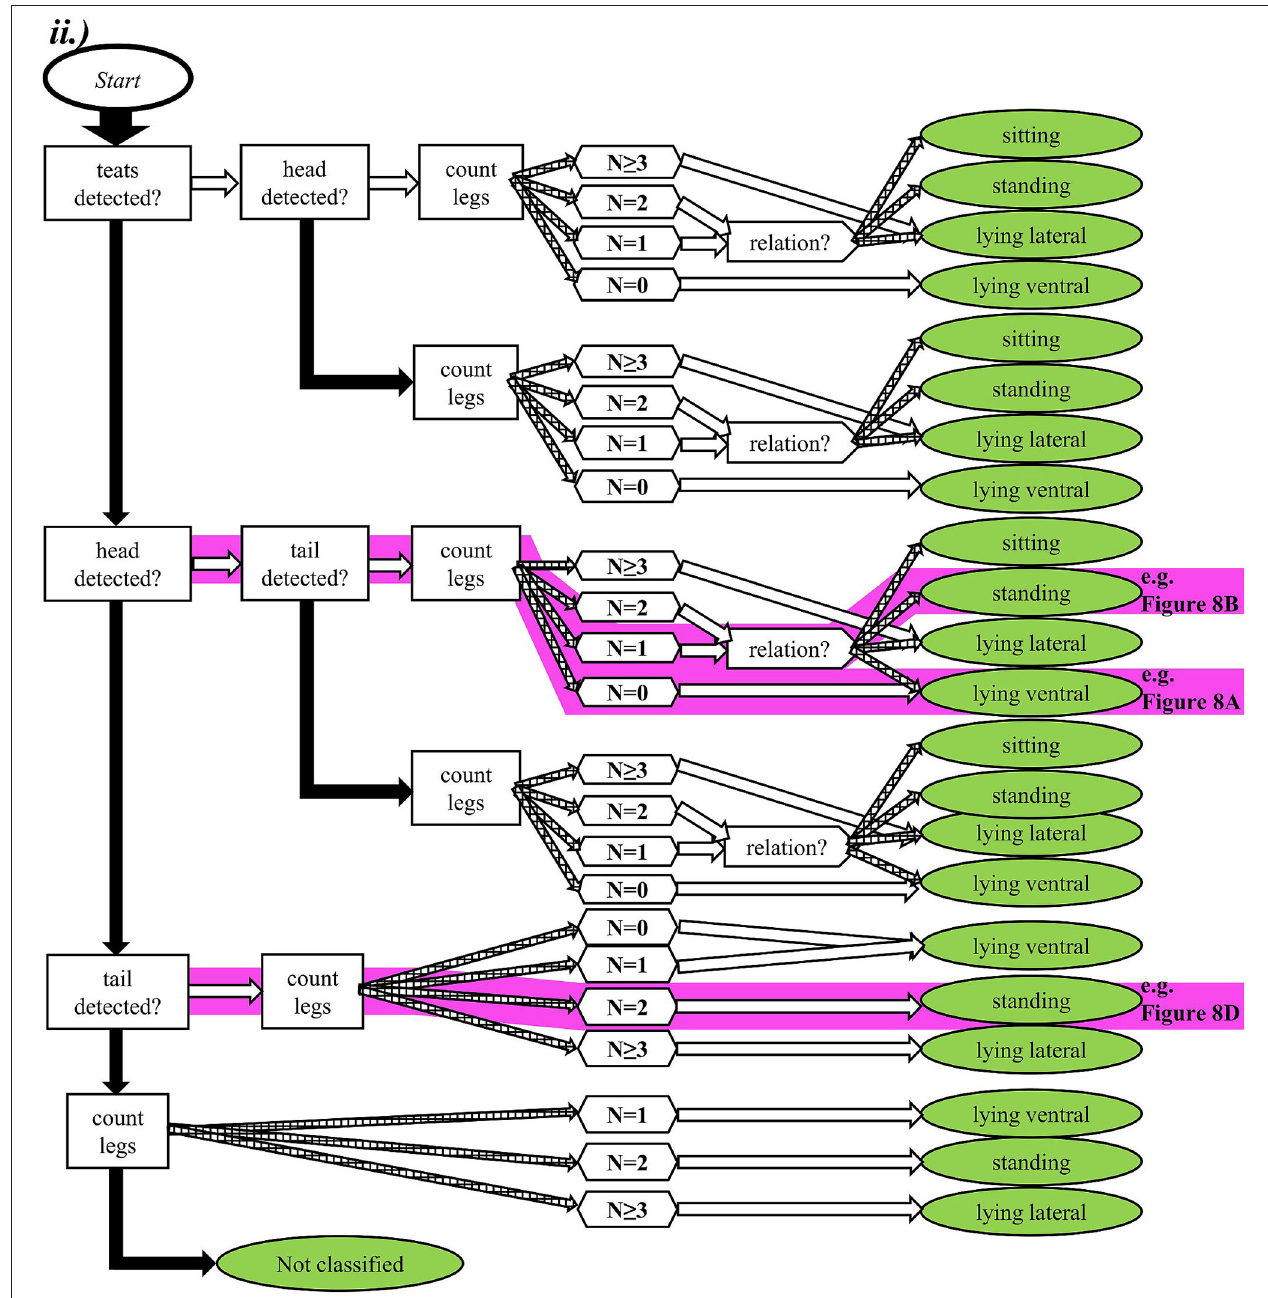
FIGURE 4 | Illustration of the hierarchical conditional statement for the body posture classification of a sow. White arrow means “yes,” black arrow “no” and striped arrows are highlighting calculation-/threshold-steps. The algorithm can be separated in four different paths + “Not classified” with up to four side paths. The final classification of a body posture (lying lateral, lying ventral, sitting or standing) depends on the location of all detected features within a path. If there are no detected features, the body posture is set to “Not classified”. The pink highlighted paths are examples of the situations in Figure 8A (lying ventral classified, although the sow is actually standing), Figure 8B (standing with detected head) and Figure 8D (standing without detected head).